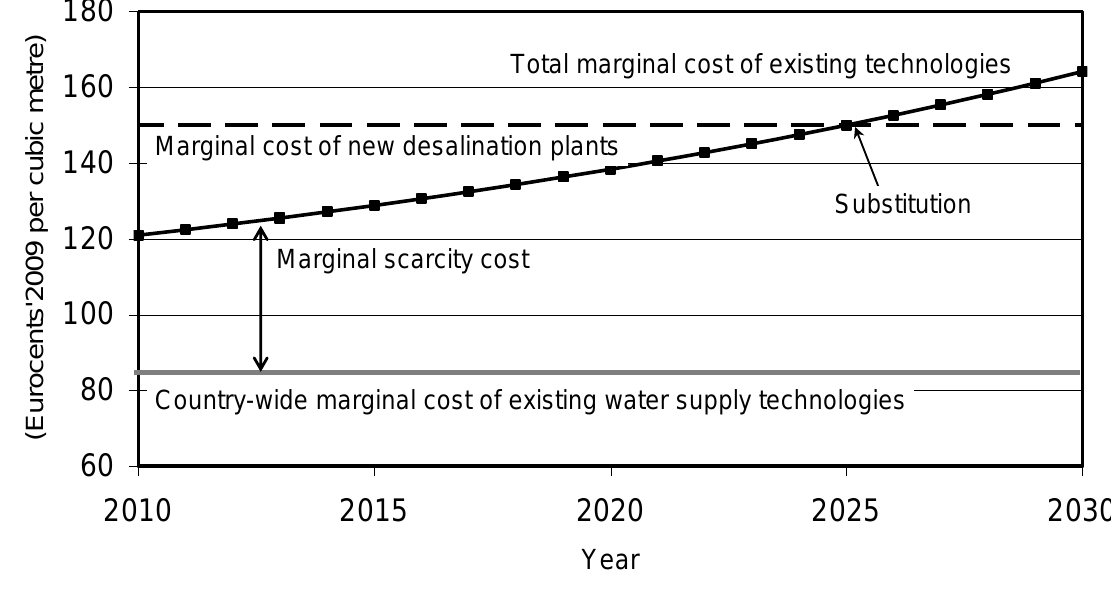
Figure 2. Evolution of marginal water supply costs in the period 2010–2030 according to results of scenario 2; from 2025 onwards existing water supply options are substituted by new desalination plants.